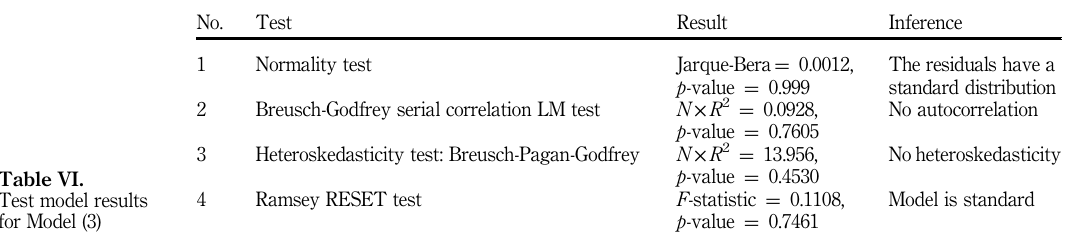
Table VI. Test model